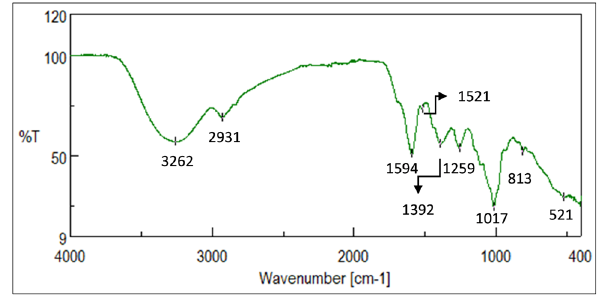
Figure 2: FTIR spectrum of